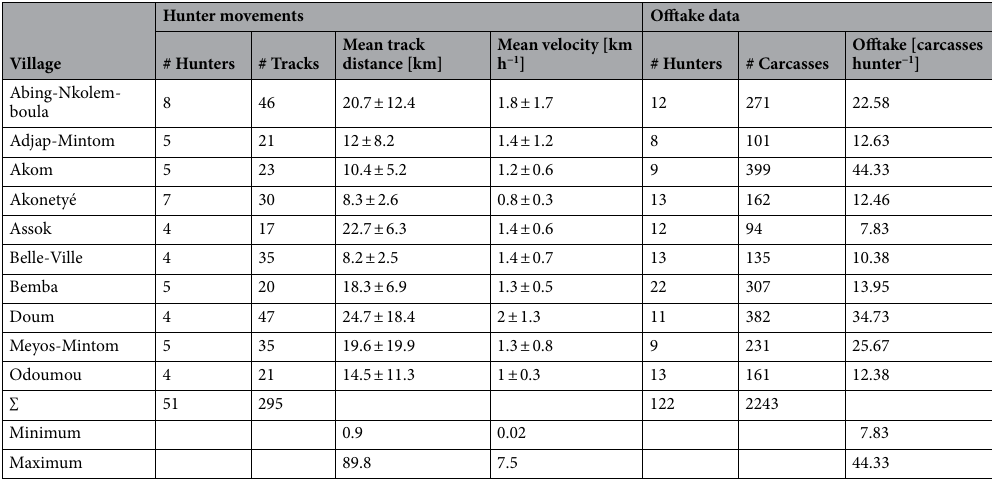
Table 1. Distances and velocities covered by hunters during hunting sessions in 10 Baka villages. Offtake data of 121 hunters have been published by Ávila Martin et al. (2020) and one additional hunter was added